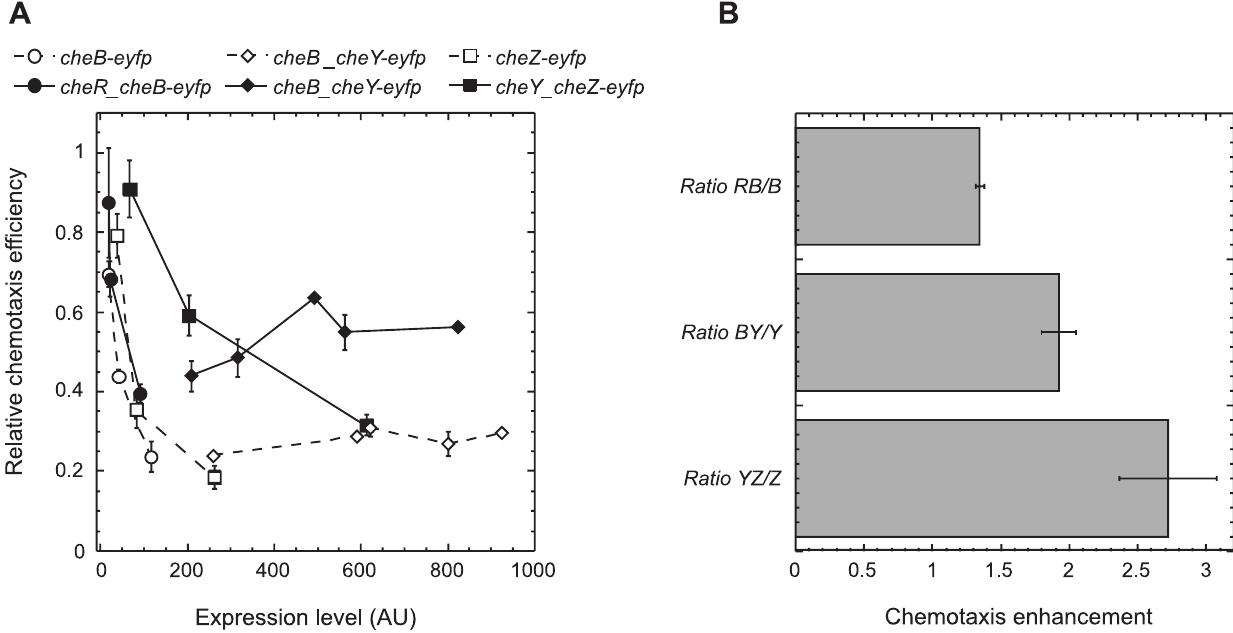
Figure 2. Improvement of chemotaxis by coexpression of signaling proteins. (A) Dependence of the chemotaxis-driven spreading of bacteria on soft agar (swarm) plates on the protein expression level for monocistronic (open symbols, dashed lines) or bicistronic (filled symbols, solid lines) constructs. Protein expression from pTrc99A-based plasmids pVS138 ( cheB-eyfp ) and pVS145 ( cheR _ cheB-eyfp ) in strain RP4972 ( D cheB ) and pVS64 ( cheZ-eyfp ) and pVS305 ( cheY_cheZ-eyfp ) in strain VS161 ( D cheZ ) was induced by 10, 25, or 100 m M IPTG. A nontranslated 316-nucleotide fragment of cheB was included upstream of the cheY start codon in pLL33 ( 2 316_ cheY-eyfp ) plasmid to achieve expression comparable to pLL36 ( cheB _ cheY-eyfp ) construct (see Materials and Methods for details), and both constructs were expressed in strain VS100 ( D cheY ) under weaker pBAD promoter induced by 0%, 0.0005%, 0.001%, 0.003%, 0.005%, or 0.01% arabinose. Expression levels were measured in liquid cultures grown under the same induction as described in Materials and Methods. Chemotaxis efficiency was determined as the size of a swarm rings and normalized to that of wild-type strain RP437 transformed with either a pTrc99A (for pVS138, pVS145, pVS64, and pVS305) or a pBAD33 (for pLL33 and pLL36) vector. (B) Enhancement of chemotactic efficiency by expression coupling. Enhancement was calculated as a ratio of chemotaxis efficiency at a given expression level of the monocistronic construct to the interpolated efficiency at the same expression level of the YFP fusion in the respective bicistronic construct in (A), and values at different expression levels were averaged. Error bars indicate standard deviations.